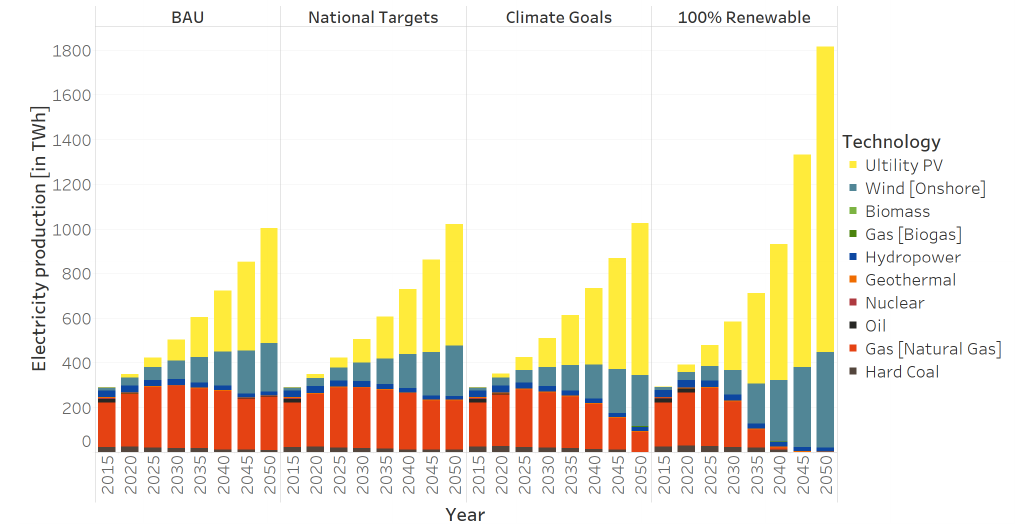
Figure 6. Electricity generation per year for all four scenarios.